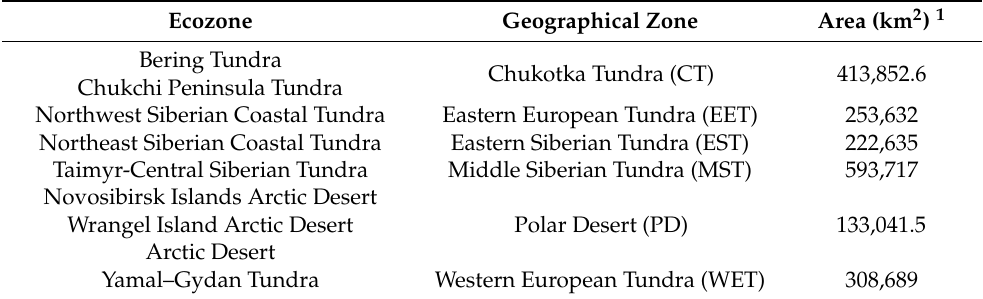
Table 1. Geographic regions of the tundra zone and the polar desert and their corresponding ecozones in the WWF scheme.